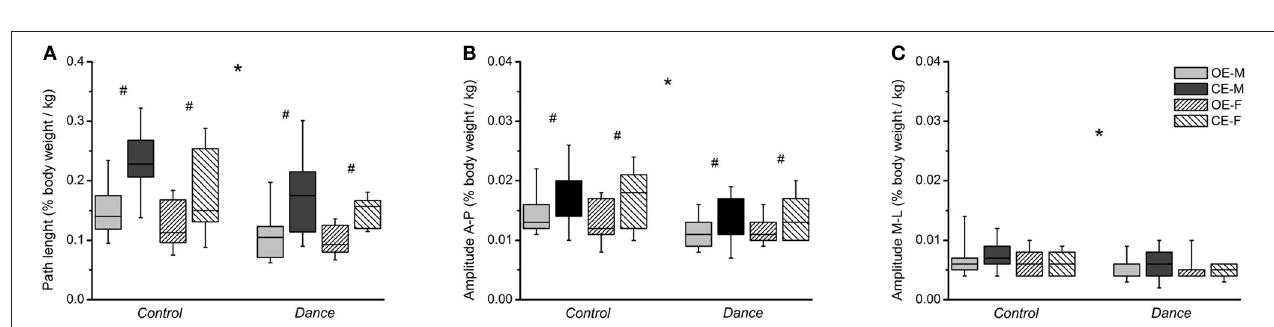
FIGURE 2 | (A) Normalized path length, (B) CoP-amplitude in the anteroposterior direction, and (C) CoP-amplitude in the mediolateral direction in the two-legged quiet stance trials with eyes open (EO) and eyes closed (EC) in the non-dancer (control) and dancer (dance) groups. (M) for men, (F) for women. *Statistically significant group effect ( p < 0.05), #statistically significant vision effect ( p < 0.05).